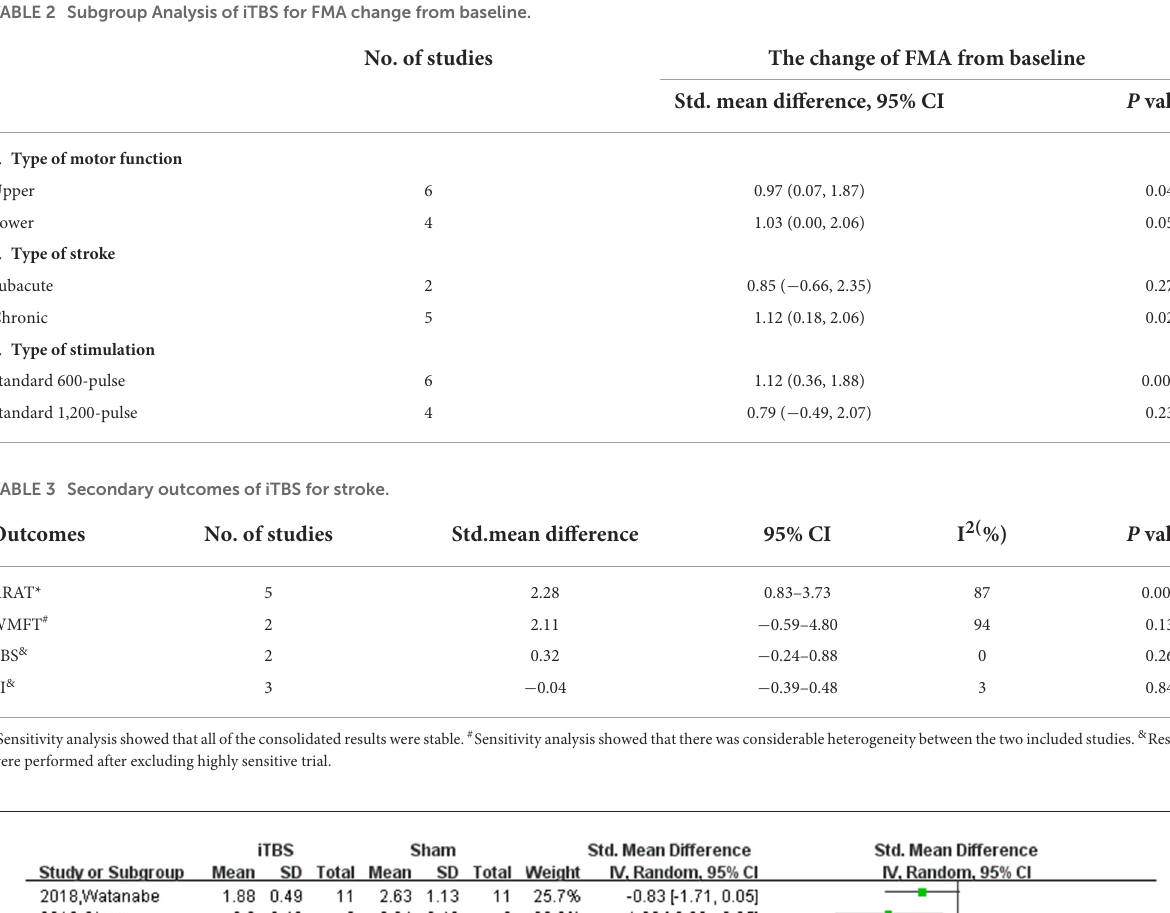
TABLE 2 Subgroup Analysis of iTBS for FMA change from baseline.